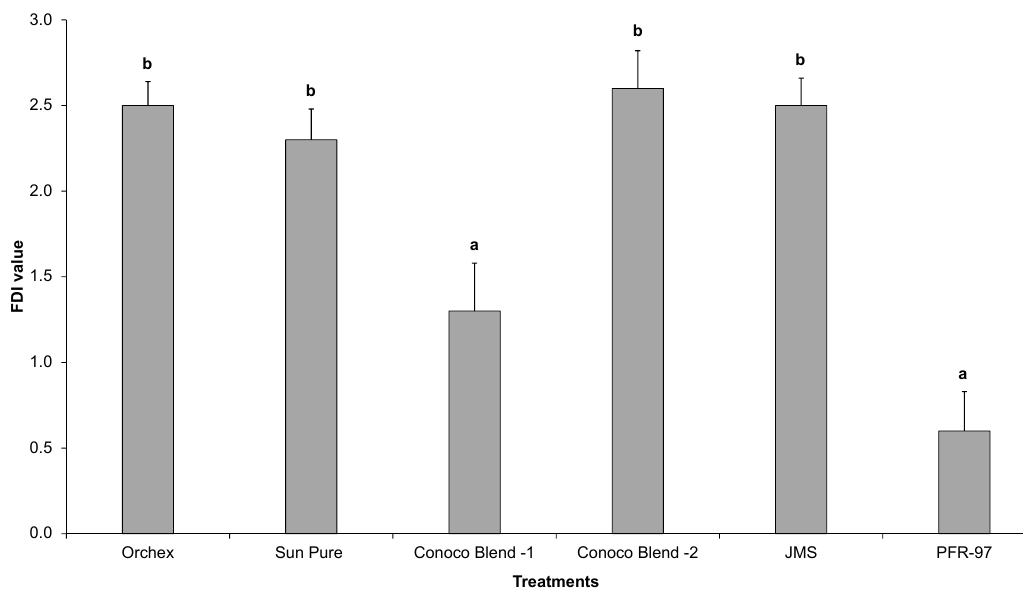
Figure 4. The mean Fungal Development Index (FDI) ± SEM value for Diaphorina citri adults after being exposed to Isaria fumosorosea (PFR-97), alone or mixed with different HMOs. Letters located above the SEM bars that are not the same are significant different (Tukey’s HSD test, p <